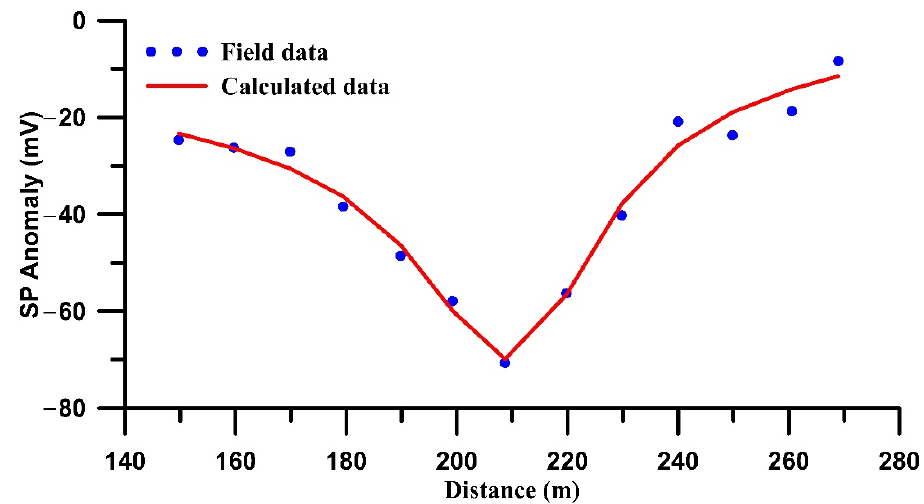
Figure 10. Fits for field data of polymetallic deposit, Rudnyi Altai, Russia. Table 4. Interpretation of the polymetallic deposit, Rudnyi Altai, Russia. Parameters